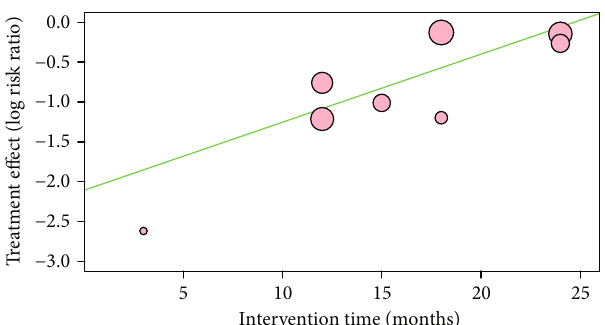
Figure 3: Metaregression analysis of the association between the e ffi cacy of special therapeutic footwear and intervention time.